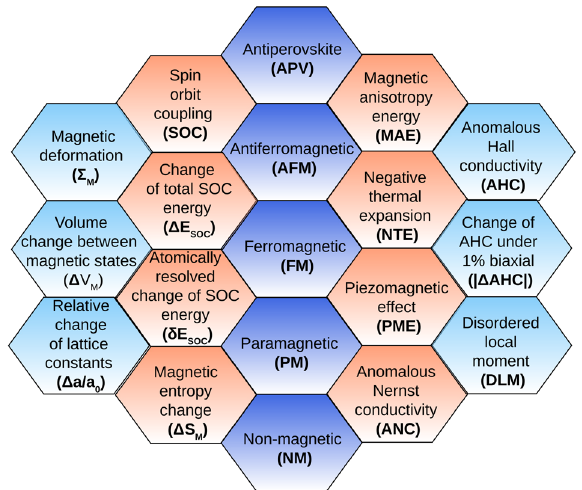
Fig. 1 Abbreviations. The list of abbreviations used in the